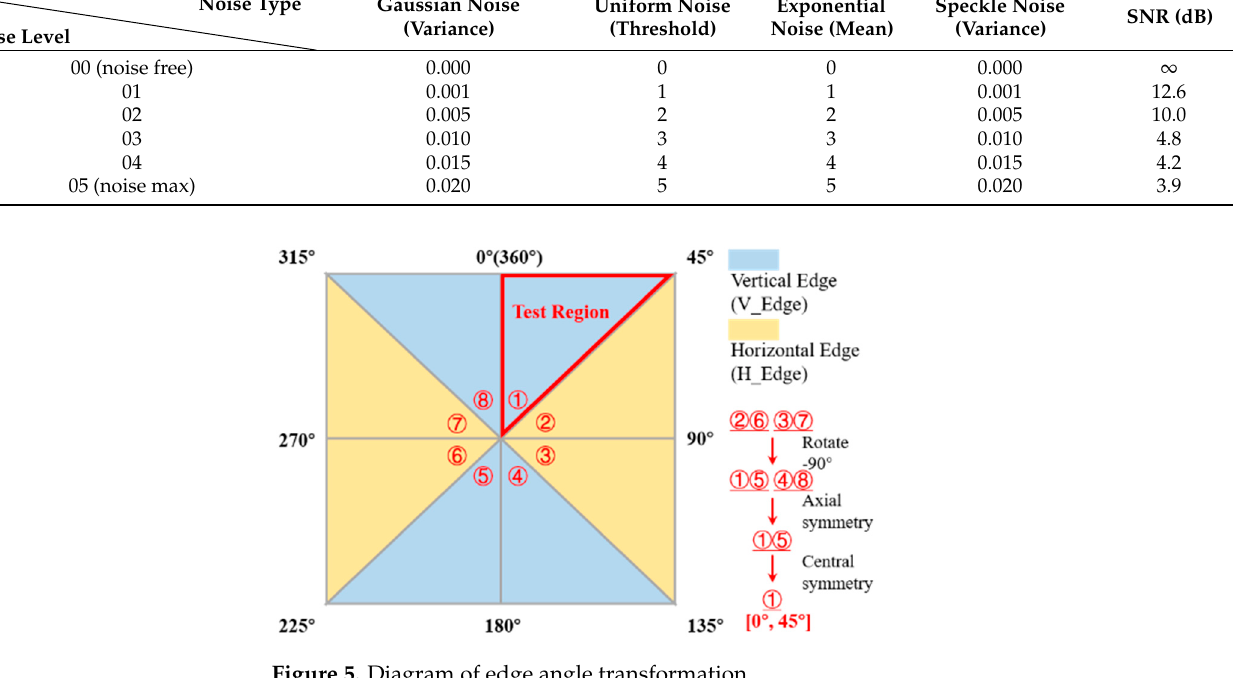
Figure 5. Diagram of edge angle transformation.